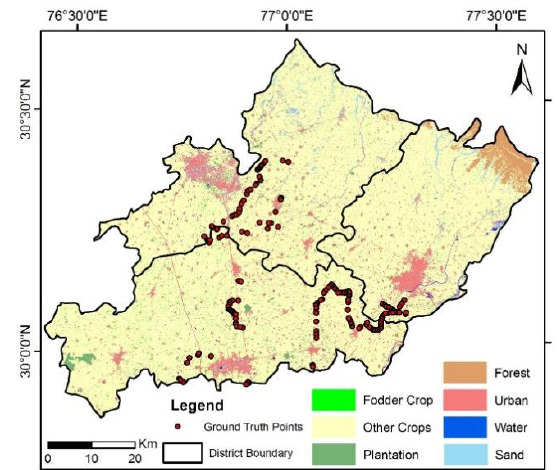
Figure 4. SVM (RBF) image of Study Area with ground truth points.